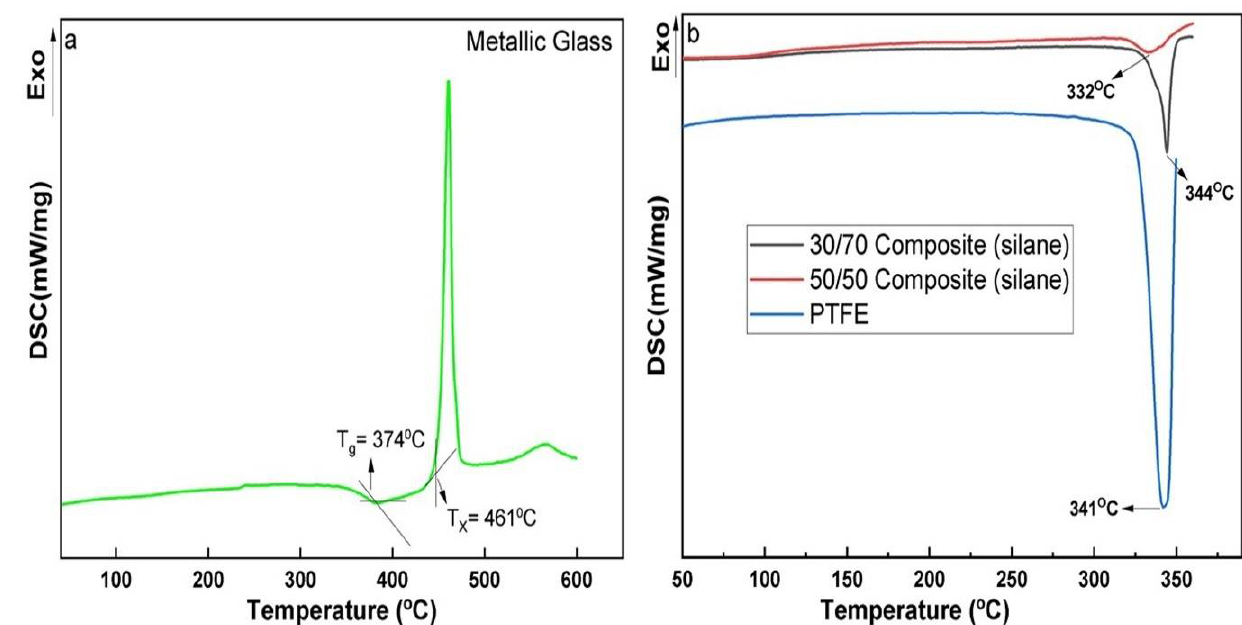
Figure 2. DSC analysis of ( a ) Zr 65 Cu 17.5 Ni 10 Al 7.5 metallic glass, ( b ) PTFE, and 30/70 and 50/50 composites with silane.